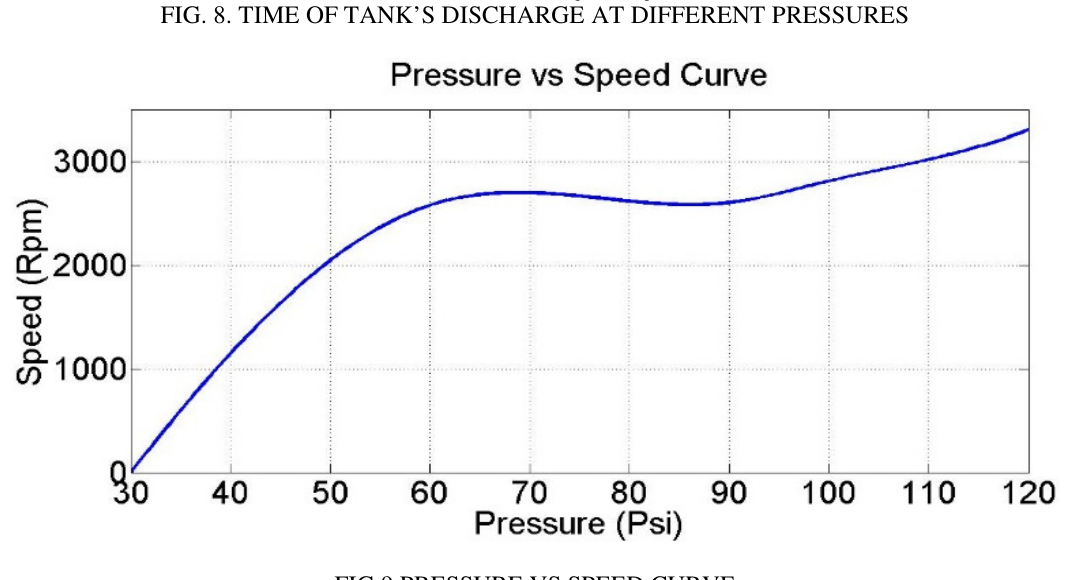
FIG.9 PRESSURE VS SPEED